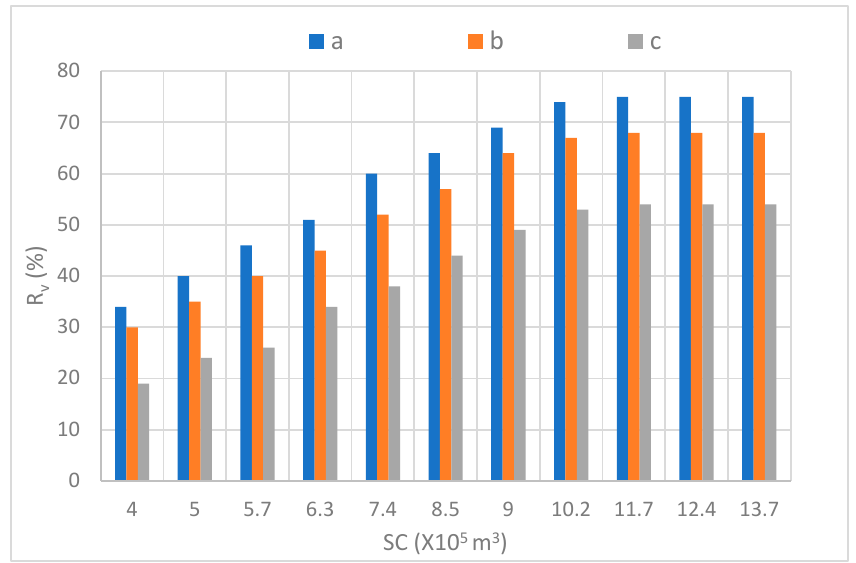
Figure 4. The percentage of volumetric reliability (R v ) vs. storage capacity (SC) for (a) wet, (b) average, and (c) dry-year climate scenarios.